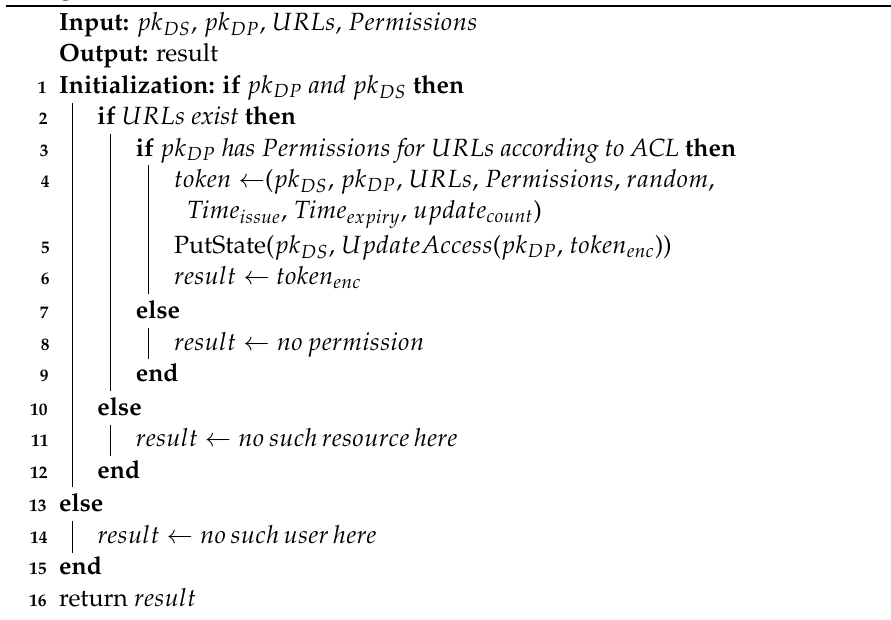
Algorithm 3: Decentralized